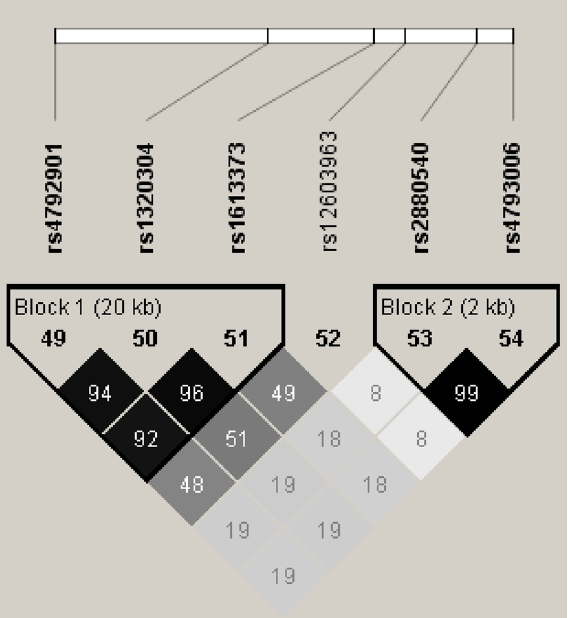
Figure 2. Linkage disequilibrium (LD) map and haplotype block structure. The pairwise LD map and haplotype blocks were constituted using the cluster of six SNPs. The SNPs are in the same order as the genomic organization on chromosome 17. Values of r 2 are indicated in each cell. The regions surrounded by a black line are haplotype blocks.